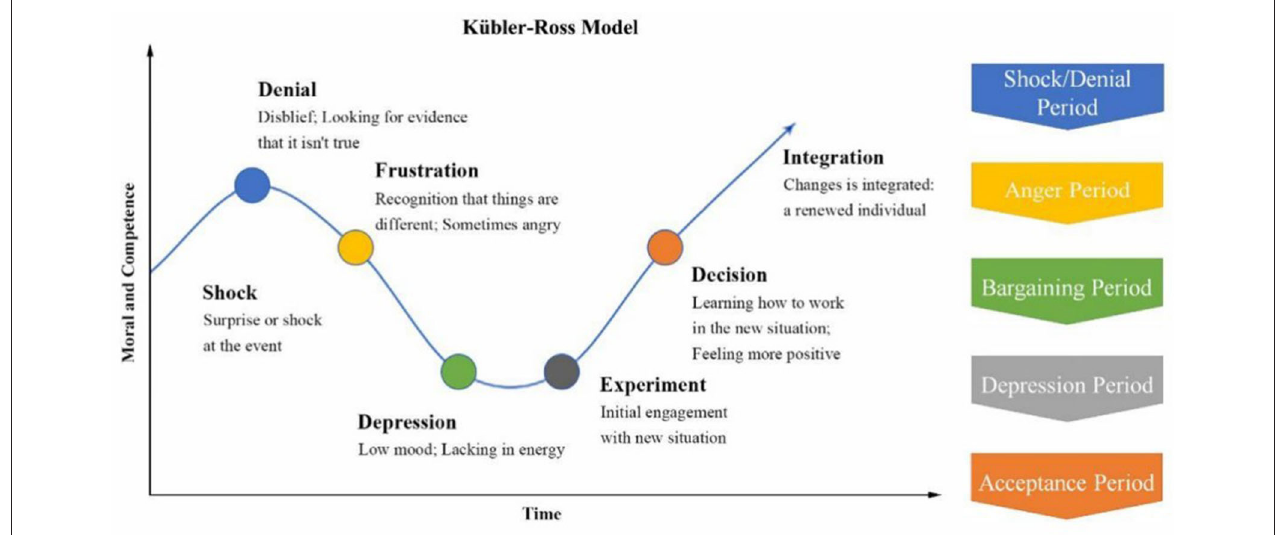
FIGURE 1 | Kubler–Ross change